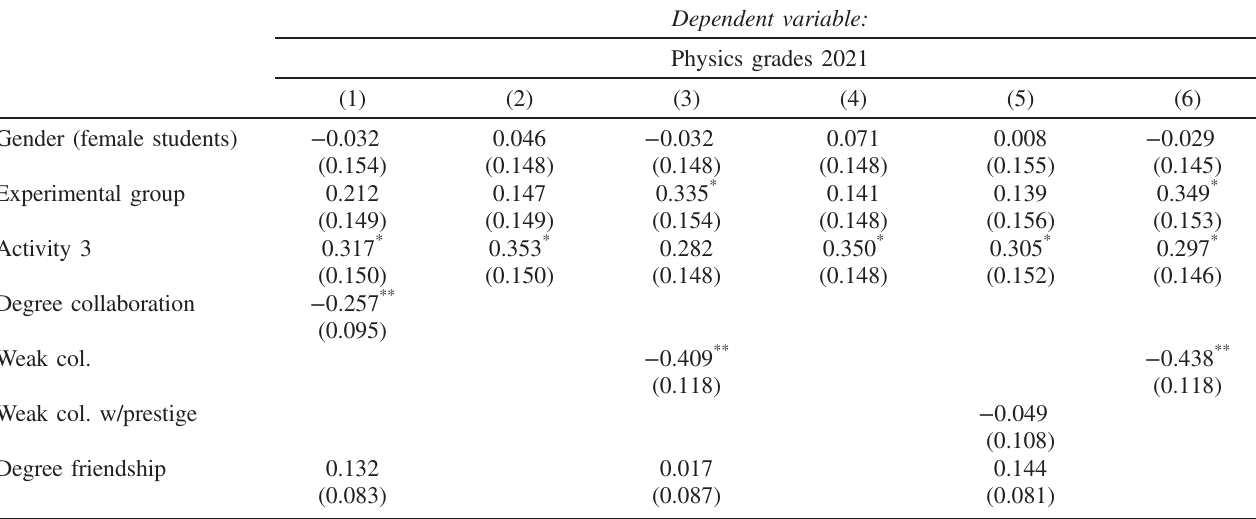
TABLE VIII. Difference and difference